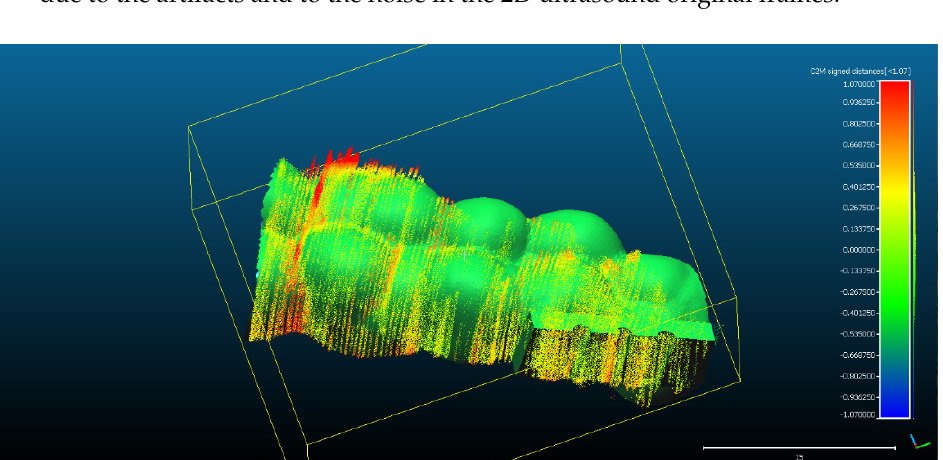
Figure 7. The spatial distribution of the 272,189 3D ultrasonographic points compared to the reference object (CAD project STL format) after alignment. The distribution of the alignment errors is figured in the form of a colored Gaussian shape on the righthand side of the color code bar.